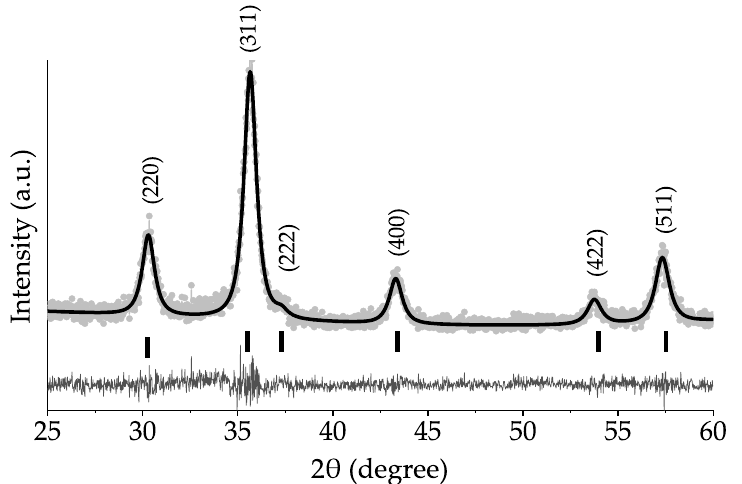
Figure 1. XRD pattern of the representative MW-HS-0 sample (gray dots) with WPPM fitting (black line); black ticks indicate reflexes of the reference pattern JCPDS No.